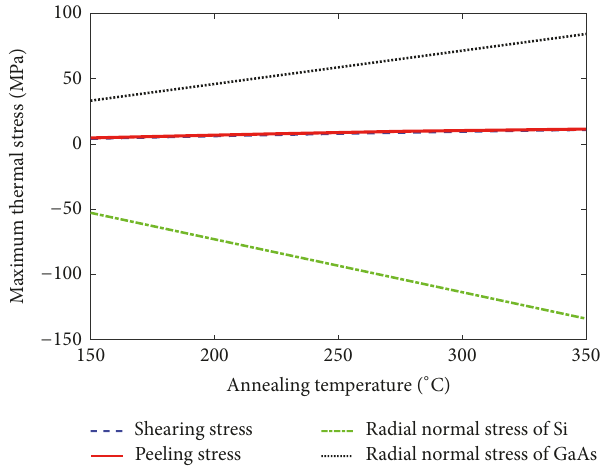
Figure 8: Maximum thermal stresses at different annealing temperatures.